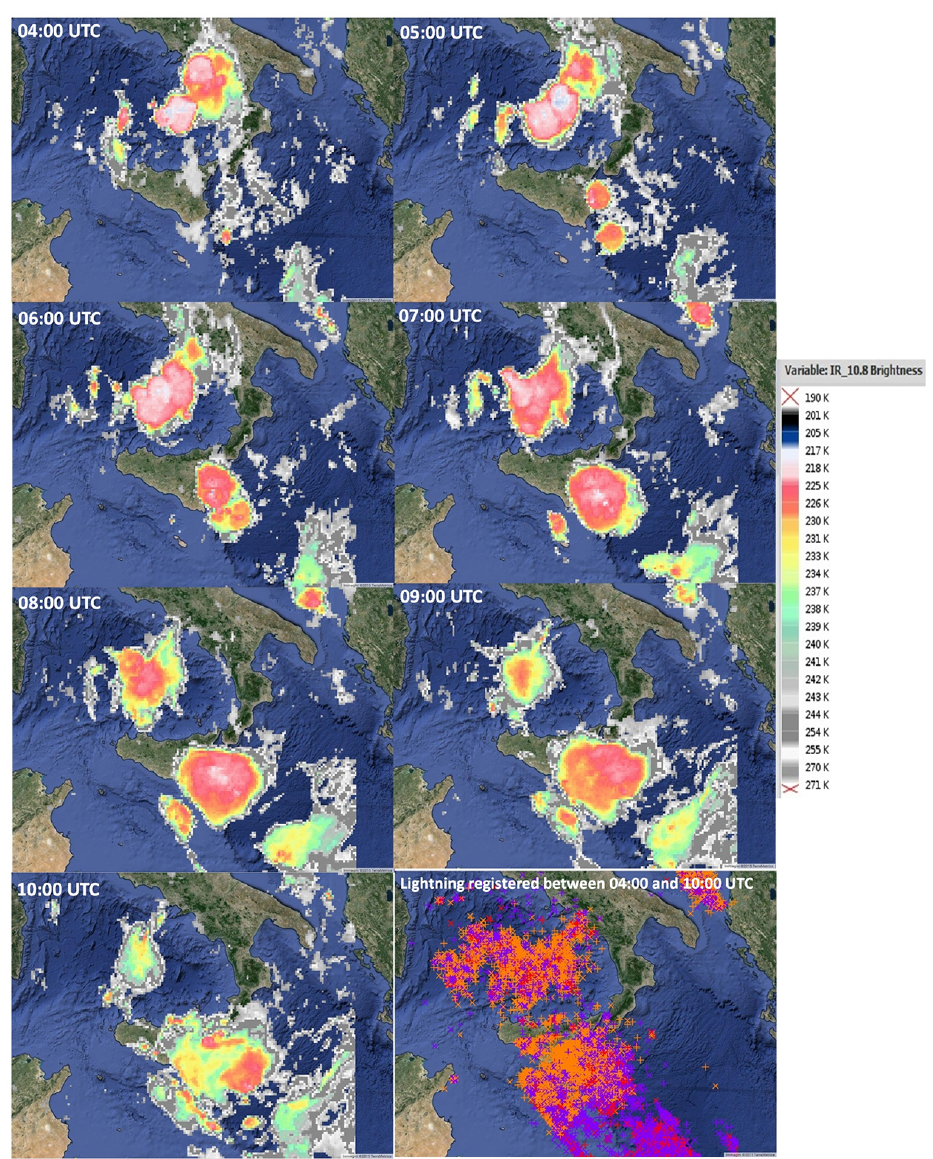
Figure 9. Brightness temperature at 10 . 8µm as retrieved on 21 August 2013 by Spinning Enhanced Visible and Infrared Imager (SEVIRI) instrument on board the Meteosat Second Generation (MSG) geostationary